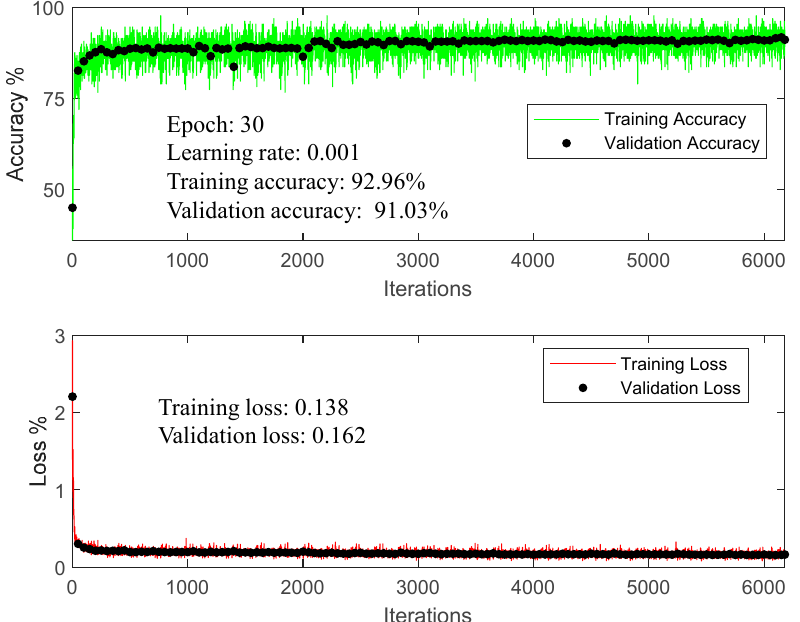
Figure 7. Training and validation of the customized deep learning model using simulation data. Here, 80% of the data (training data) was used to train the CNN, while 10% of the data (validation data) was used to evaluate the performance of the model at each iteration of the training process. The training/validation accuracy refers to the classification/validation accuracy for each mini batch of the training/validation dataset. The training/validation loss indicates the performance of the model after each iteration of optimization and denotes the sum of errors for each example of the training/validation data. From Figure 7, the overlap between the training and validation accuracies and losses as well as the validation accuracy of 91.5% imply that the network is optimally learning from the training data and could be generalized to unseen instances.